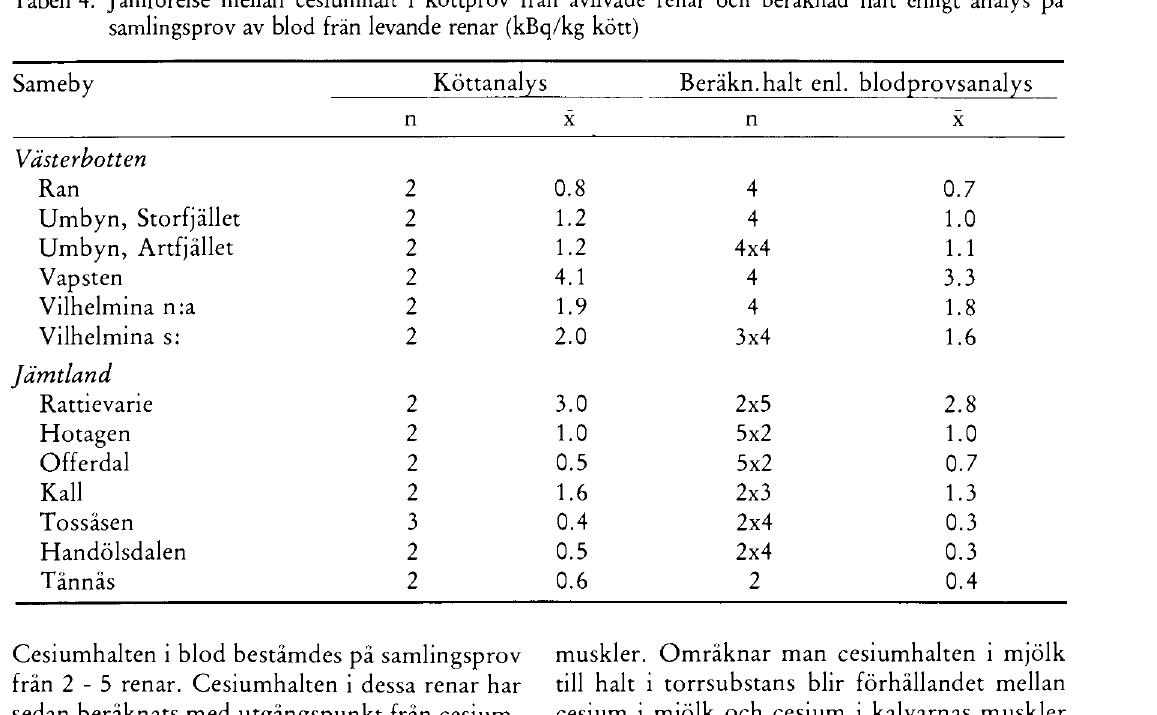
Tabell 4. Jåmforelse mellan cesiumhalt i kottprov från avlivade renar och beråknad halt enligt analys på samlingsprov av blod från levande renar (kBq/kg kott)